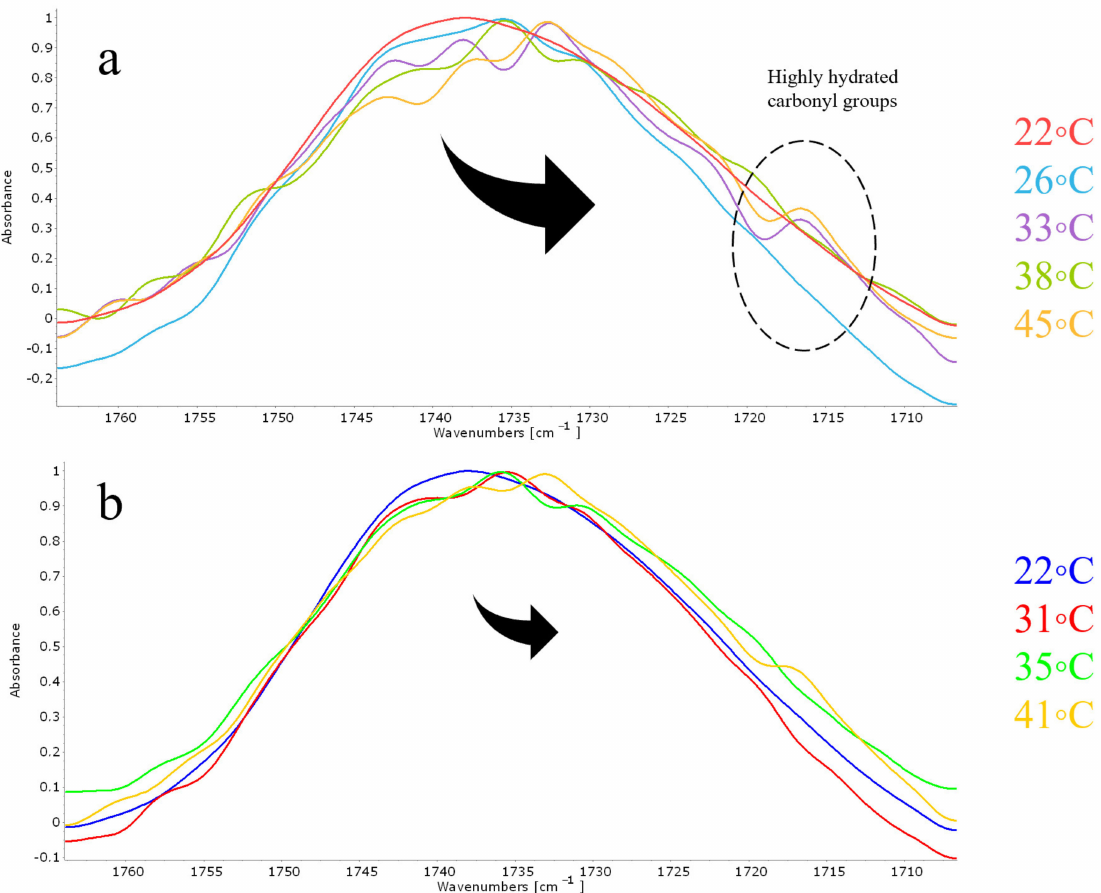
Figure 7. Normalized ATR-FTIR spectra of DPPC:CL 80:20 loaded with pirfenidone: carbonyl group area. ( a ) Spectra recorded at the temperature of maxima on the thermogram. ( b ) Spectra recorded at the temperature of minima on the thermogram. Total lipid concentration 5 mg/mL. 0.02 M Na phosphate-buffered solution, pH